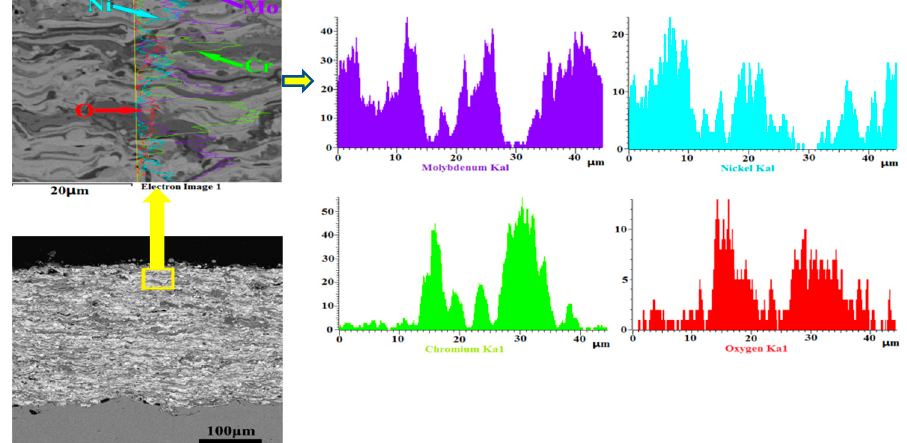
Figure 21. SEM image and EDS analysis of the MoB/NiCr coating after an immersion test in molten zinc for 360 h.